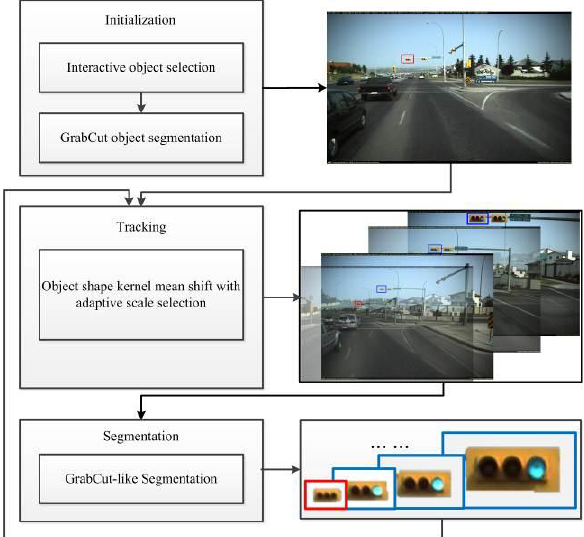
Figure 1. Diagram of the proposed